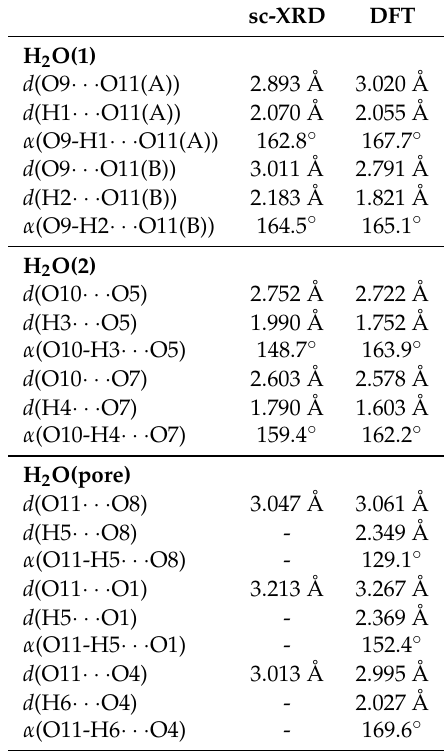
Table 2. Hydrogen bond distances and angles in AlPO 4